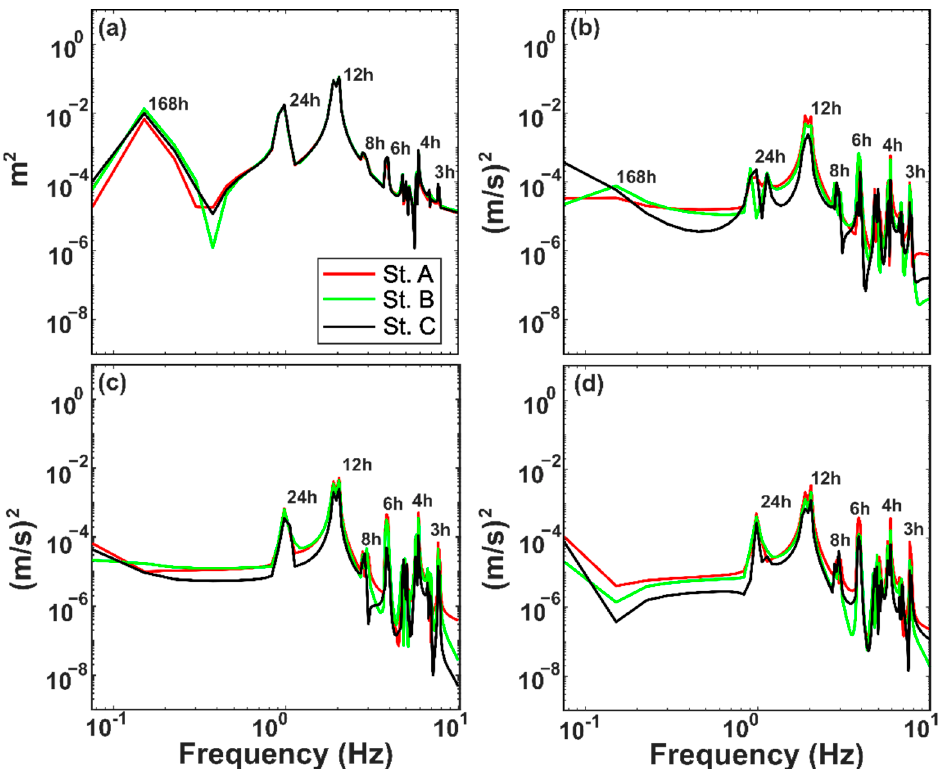
Figure 6. The power spectrum of water elevation ( a ) and current velocity in upper ( b ), mid-depth ( c ), and lower ( d ) depths at Stations A, B, and C.